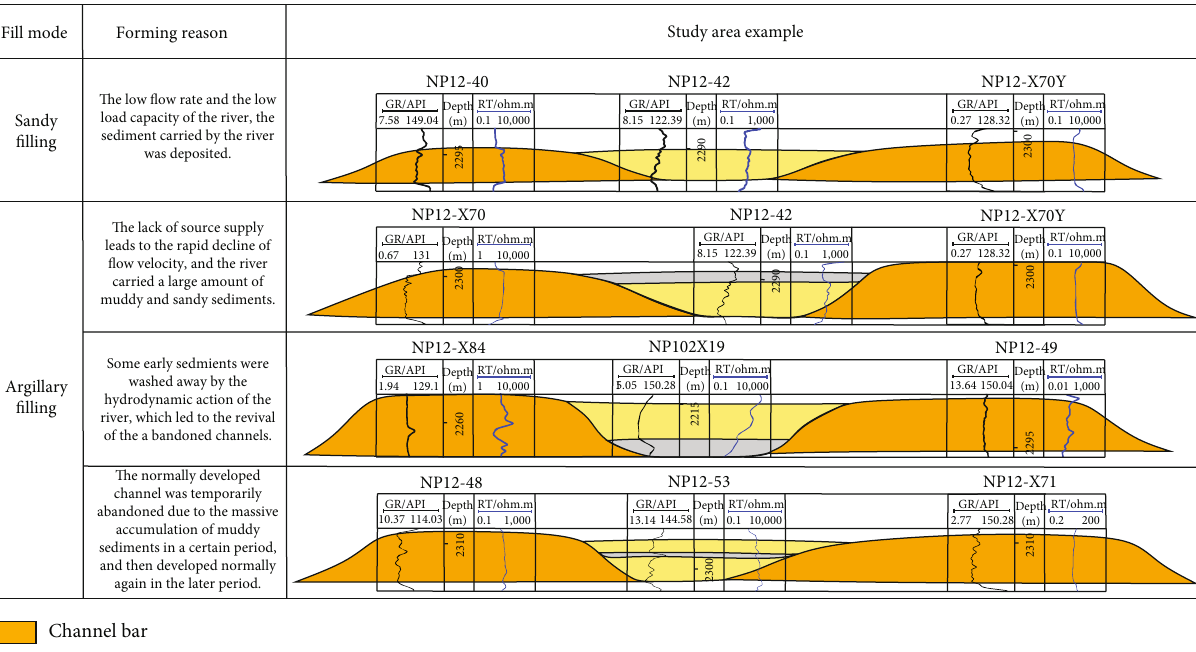
Figure 7: Filling pattern of the braided river in the study